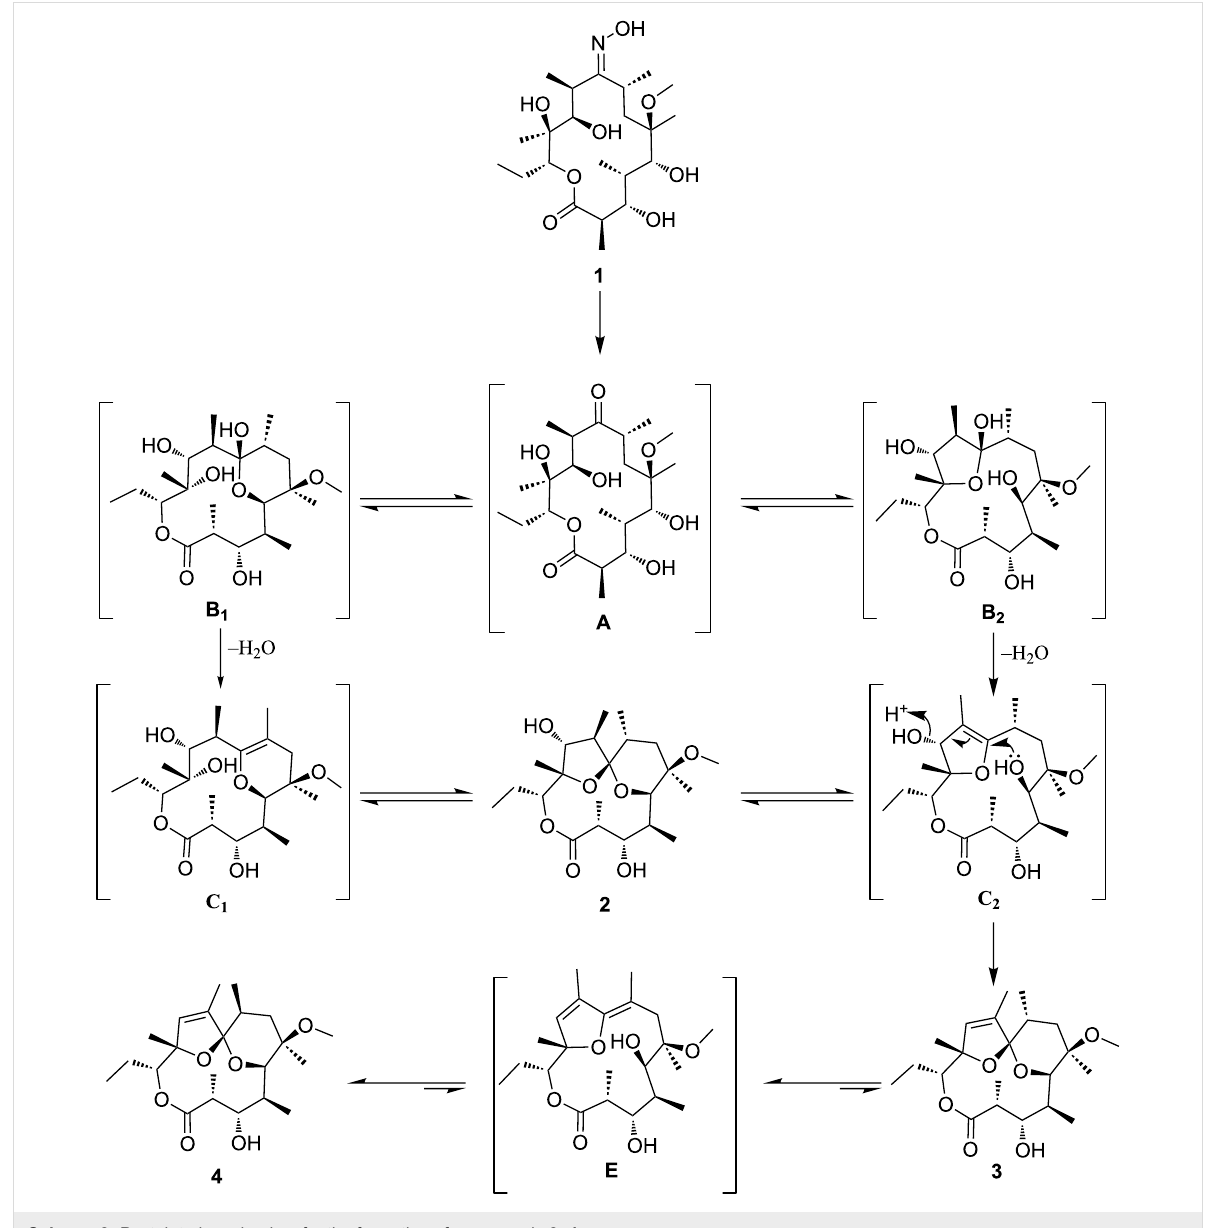
Scheme 2: Postulated mechanism for the formation of compounds 2 – 4